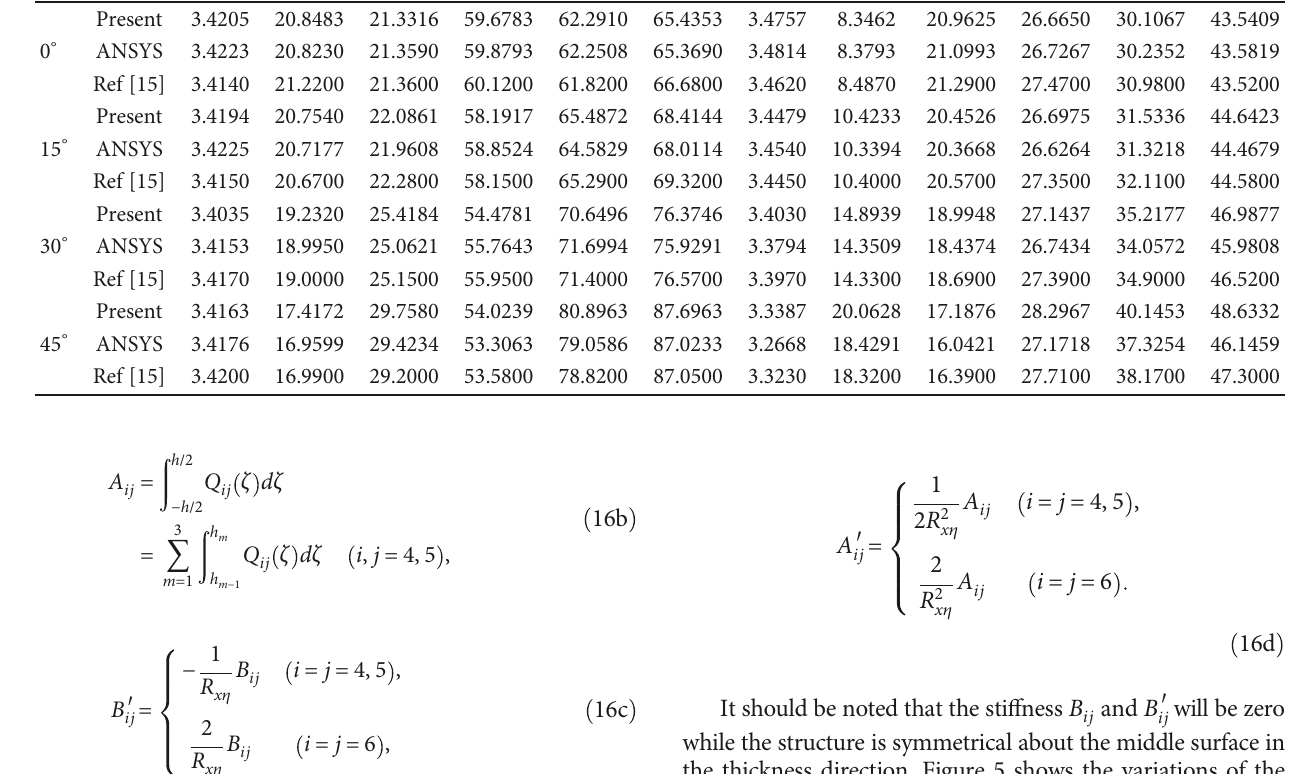
Table 3: Comparison of nondimensional frequency parameters for the fi rst six modes of homogeneous material blade ( h = 20 , μ = 0 3 ).